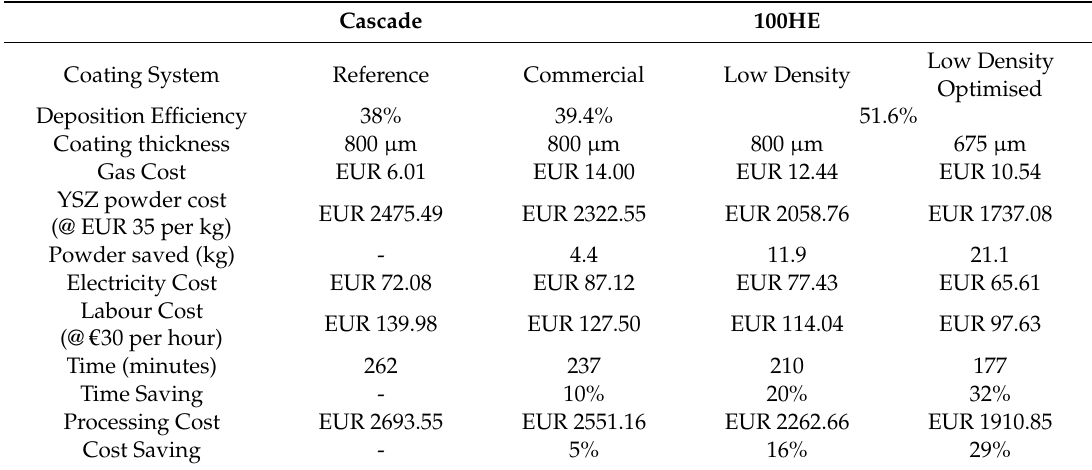
Table 4. Comparison of coatings manufacturing costs for a single idealized component. Cascade 100HE Coating System